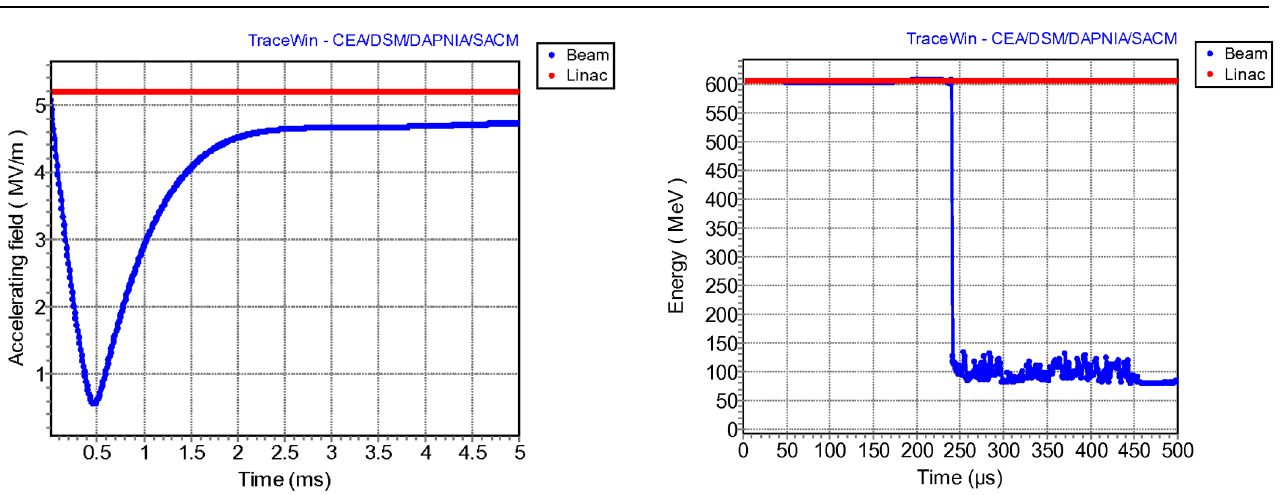
FIG. 7. (Color) Output beam energy at the linac end.FIG. 5. (Color) Field in the failed cavity.